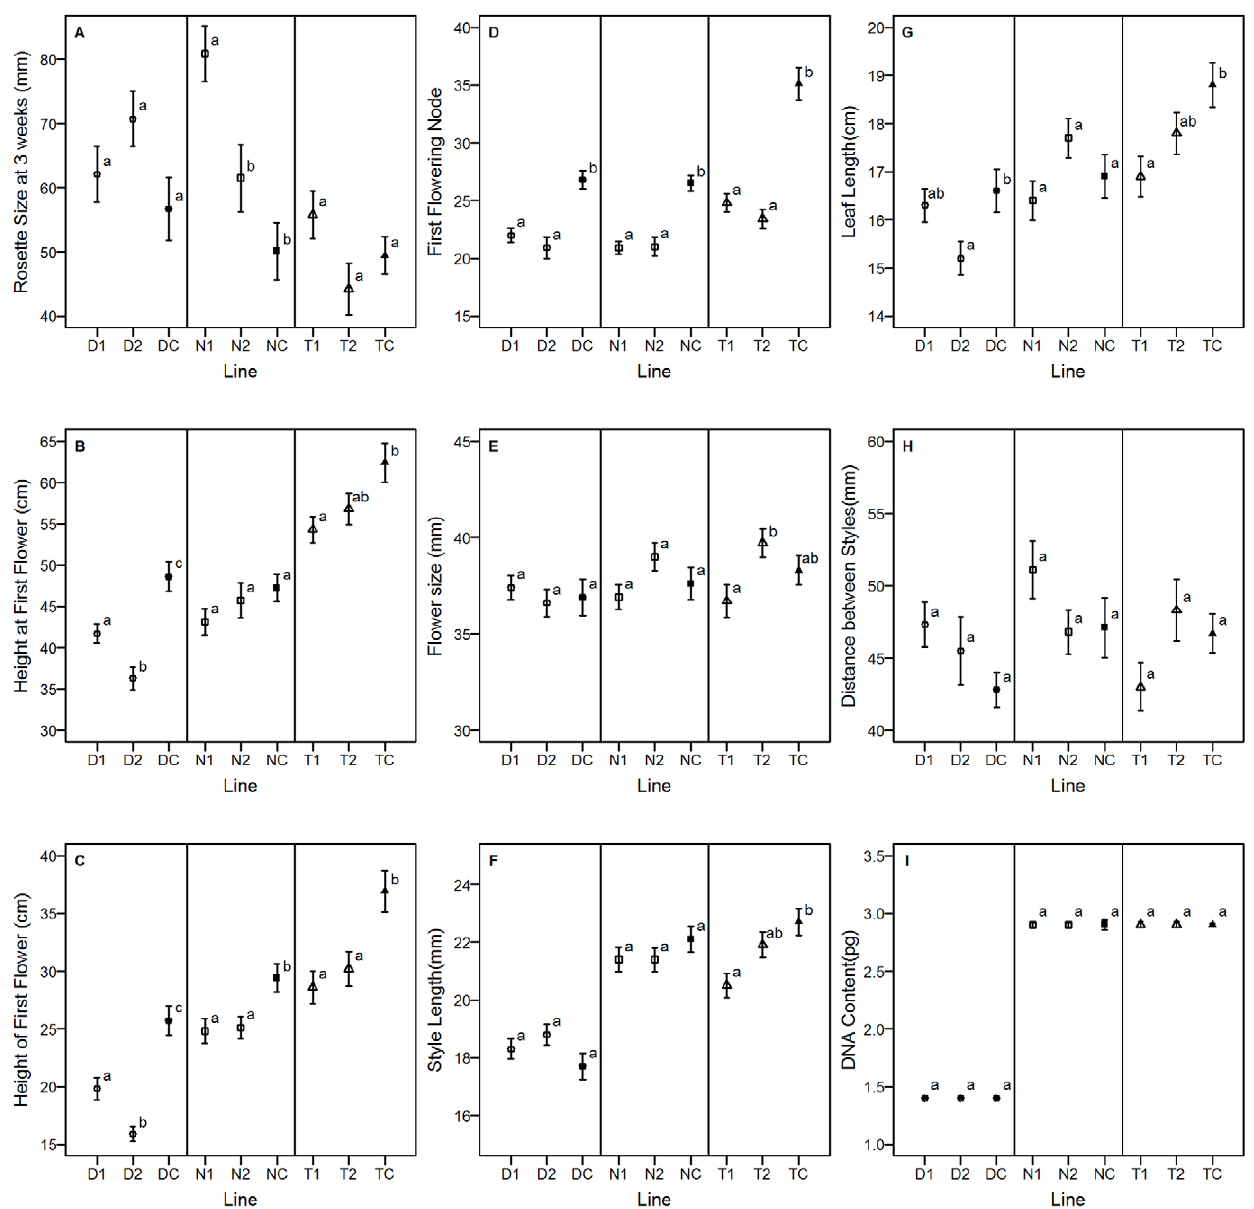
Figure 2. Correlated responses to selection. Correlated responses to selection across lines within ploidies for the fourth generation (D1, D2=Diploid line 1 and 2, DC=Diploid Control; N1, N2=Neoautotetraploid line 1 and 2, NC=Neoautotetraploid Control; T1, T2=Extant Autotetraploid line 1 and 2, TC=Extant Autotetraploid Control). Means with standard error bars are presented with different letters indicating significant differences at the p , 0.05 level or less using Tukey’s HSD within the ploidy for A) rosette size three weeks after planting (mm), B) total plant height at first flower (cm), C) height of first flower (cm), D) number of nodes produced before the first node with a flower, E) flower size across opposite petals (mm), F) style length from the base of the flower to end of fully reflexed stigma (mm), G) leaf length from stem to tip (cm), H) distance between styles of fully opened adjacent flowers (mm), and I) DNA content as measured by flow cytometry (pg). doi:10.1371/journal.pone.0044784.g002 founders, as the original material was derived from different source populations. The neotetraploid base population for this experi- ment was derived from the progeny of diploid individuals from six locations within the diploid-tetraploid hybrid zone of the Canadian Rocky Mountains (and only five locations were used